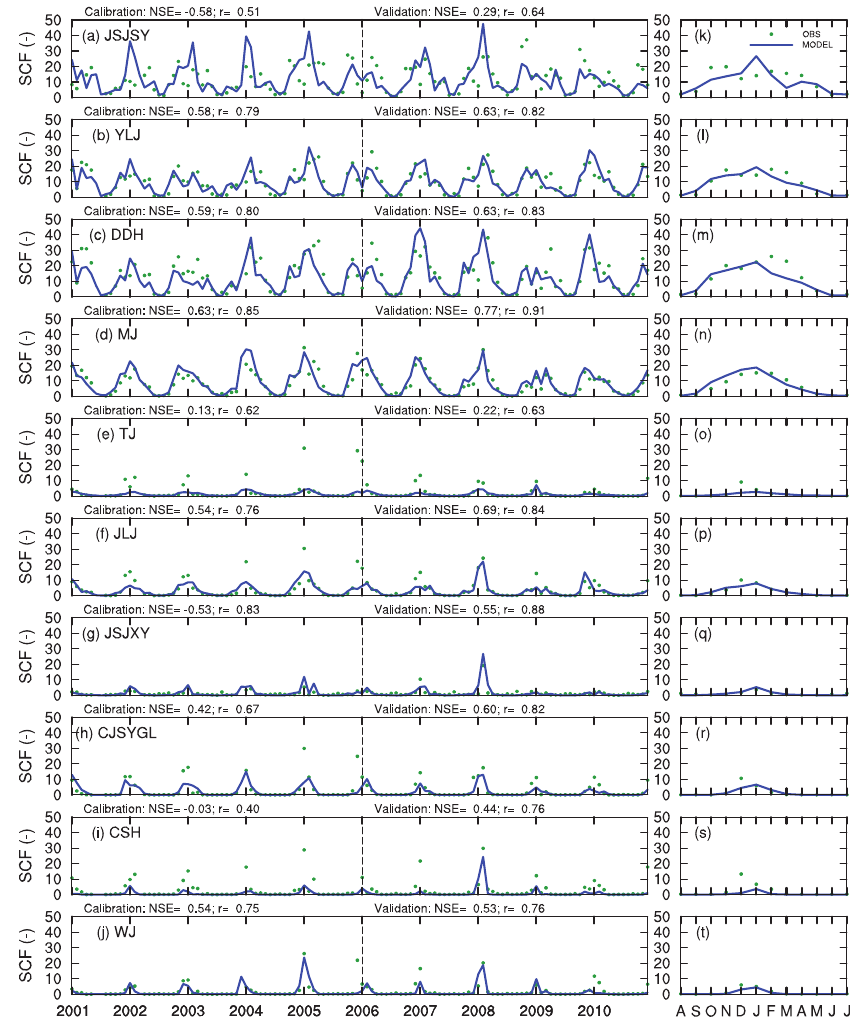
Figure 2. Comparison between the modeled and remote sensing retrieved (MOD10CM) spatial average snow cover fraction (SCF) in then sub-regions ( a – j ) during the calibration period (2001 to 2005) and the validation period (2006 to 2010). The monthly climatology SCF averaged between 2001 and 2010 ( k – t ) is also